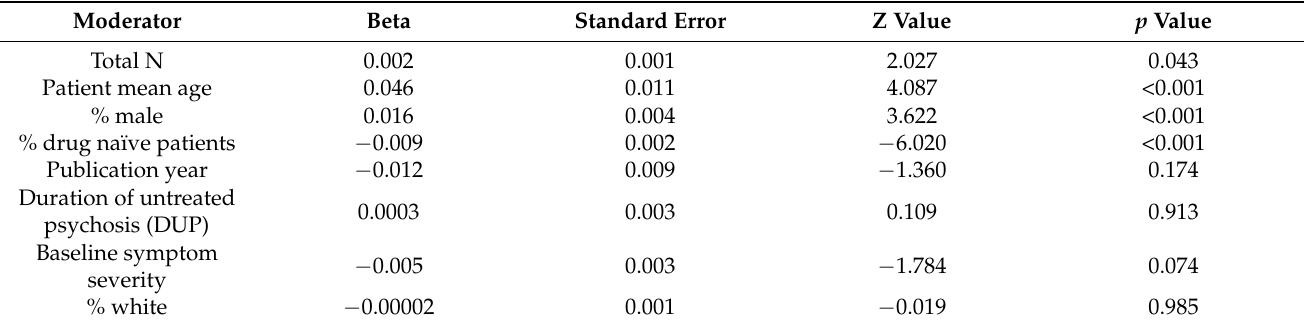
Table 2. Results of meta-regression on the difference in BDNF levels between First Episode Psychotic Patients and Healthy Controls at